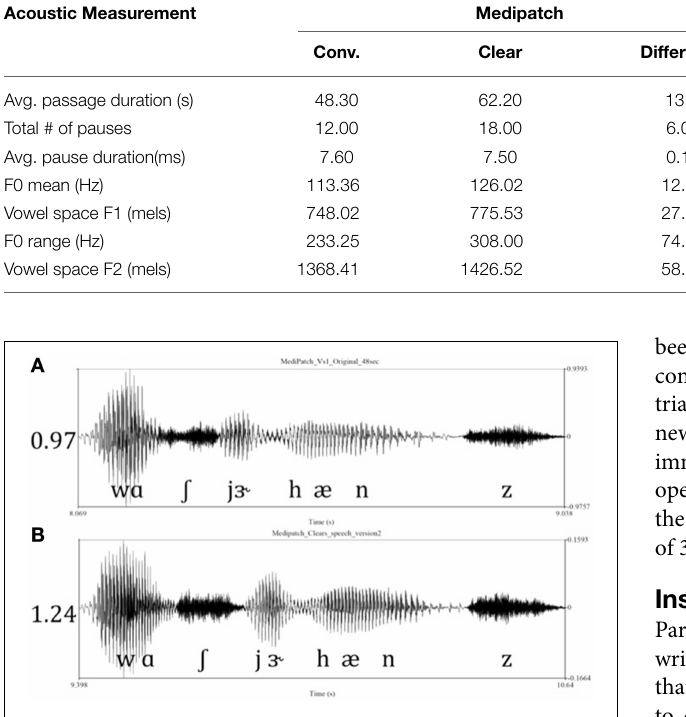
FIGURE 2 | The Praat waveforms: Two listening conditions. The waveforms depict the phrase “wash your hands” from the medipatch vignette. The two listening conditions: (A) 0.97s, original format, conversational speech technique (196 spm); (B) 1.24s, spoken with clear speech technique (152 spm). Note in clear speech, the temporal-spectral enhancement can be appreciated by the increased durations of the vowels and increased amplitudes of the